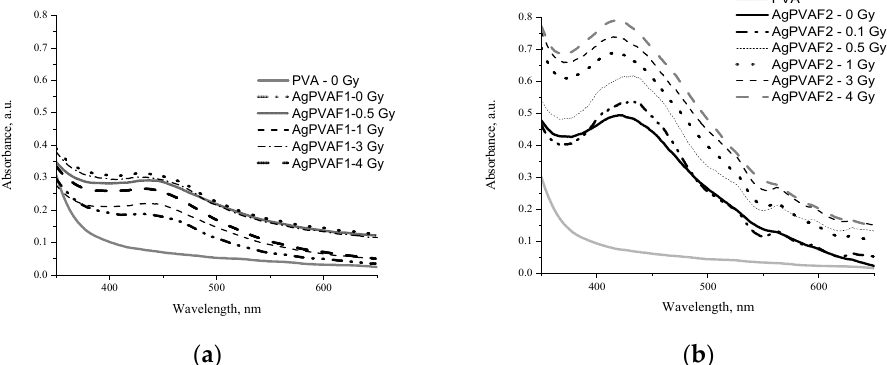
Figure 5. UV-VIS absorption spectra of experimental films containing different concentrations of AgNO 3 before and after irradiation: ( a ) AgPVAF1 (0.21 wt.%) and ( b ) AgPVAF2 (1.01 wt.%). Spectrum of pure PVA film is provided for the